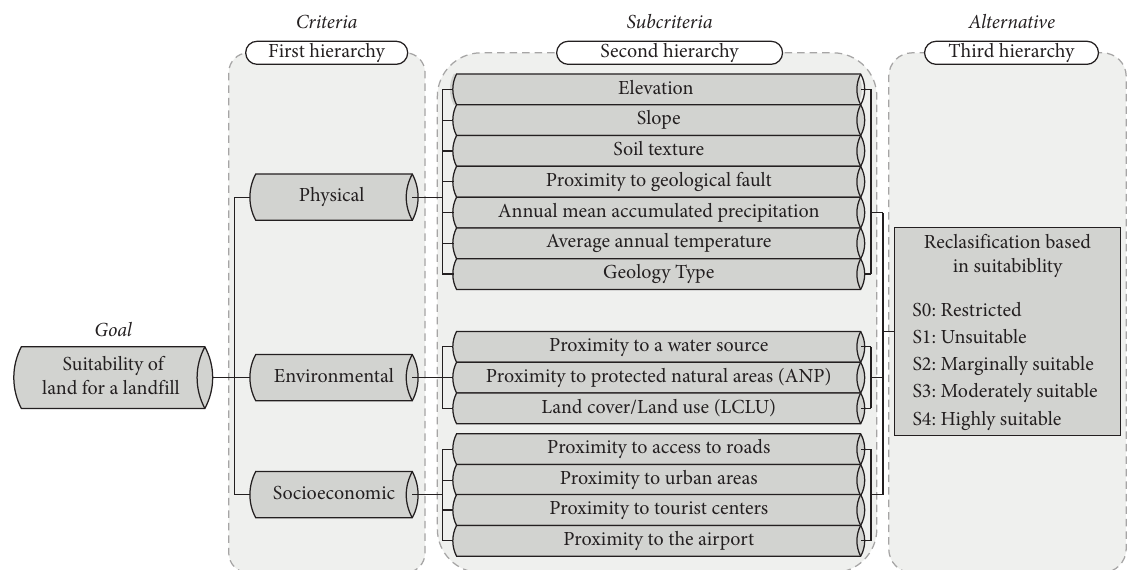
Figure 3: Hierarchical structure of the criteria and subcriteria considered in the analysis of the suitability of sites in the territory for a